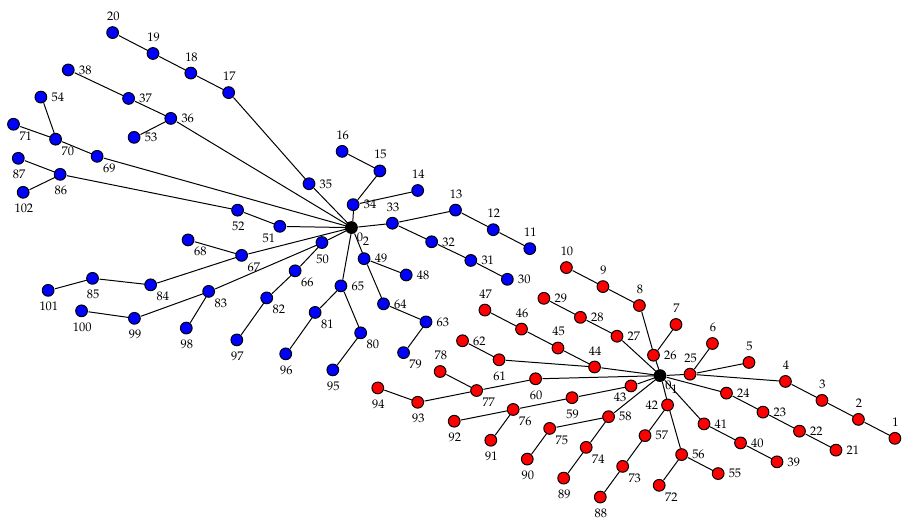
Figure 3. Optimal cable connection layout for WF-102-S2 wind farm. Table 2. Optimal costs: WF-102-S2 and WF-102-S2-W wind farm.